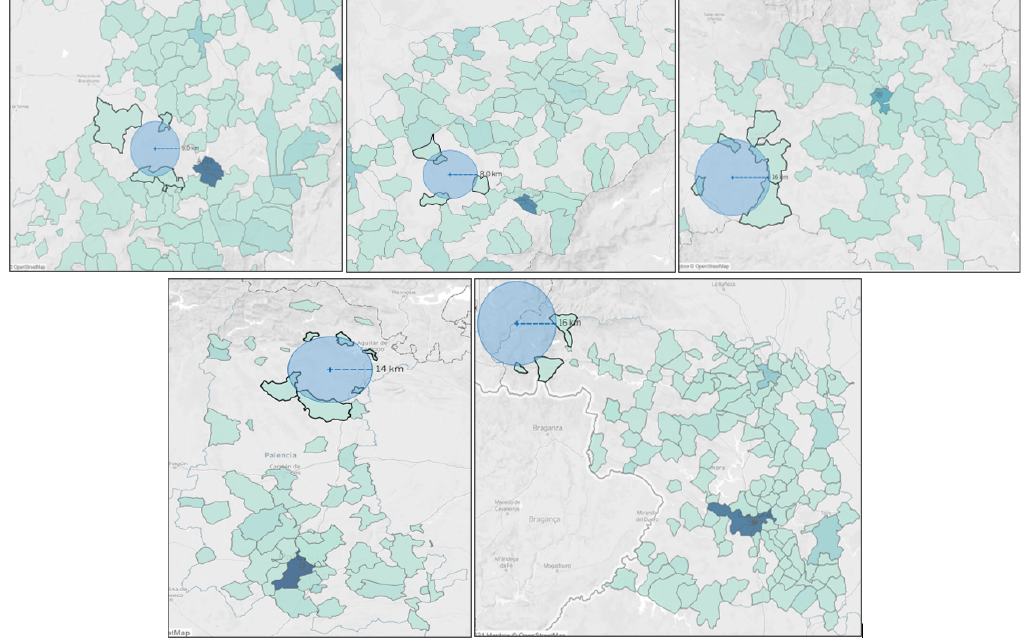
Figure 4. Distance (km) required to obtain cash from the furthest point in each province including the pharmacy network (final location). Source: Own elaboration based on Tableau Desktop profesional Edition.